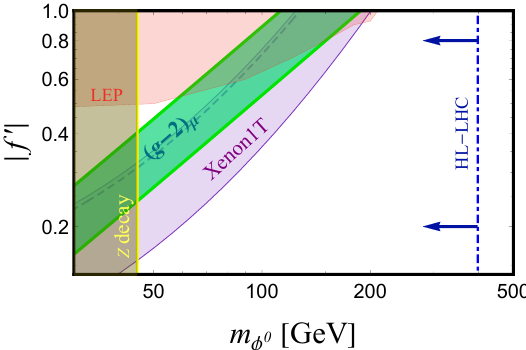
Figure 3 . The 2 σ allowed range (in green) for the muon anomalous magnetic moment measure- ment [3] at the Fermilab in the | f 0 | - m plane. The region labelled XENON1T explains the electron φ 0 recoil excess at 90% C.L [4]. The dashed line indicate the limit on neutrino magnetic moment from the BOREXINO experiment [11]. The shaded regions denote the excluded parameter space from various experiments: the light pink shaded region from the LEP experiment [12] and the yellow shaded region from the Z -decay width measurements [12, 13]. Here we have fixed f = 10 − 2 , sin α = 0 . 35 , m = m + 50 GeV and m = m + 350 h + φ 0 H + h +